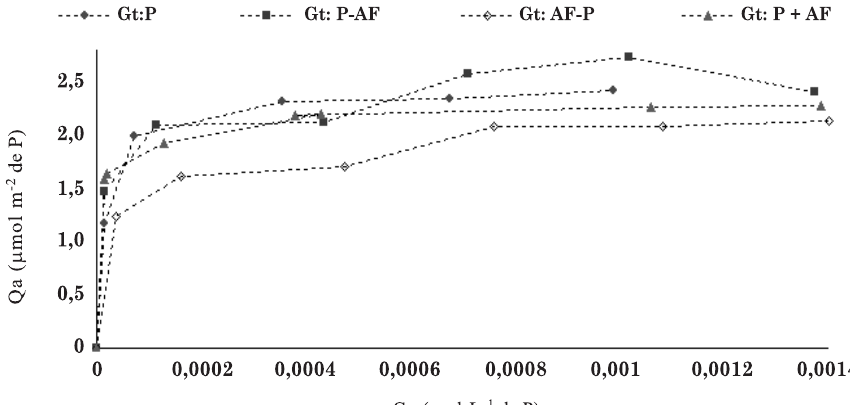
) na presença de ácido fúlvico. 2